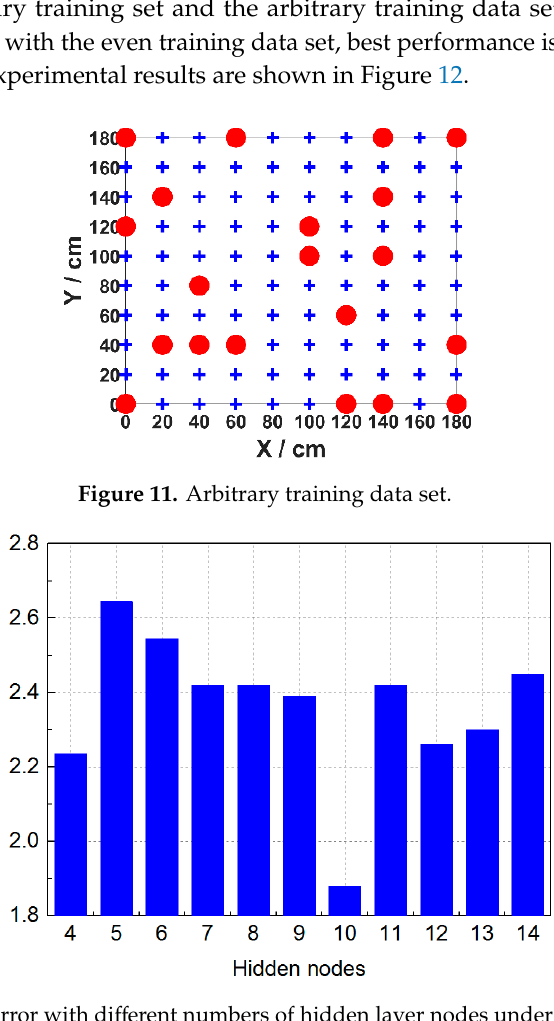
data set. data set.